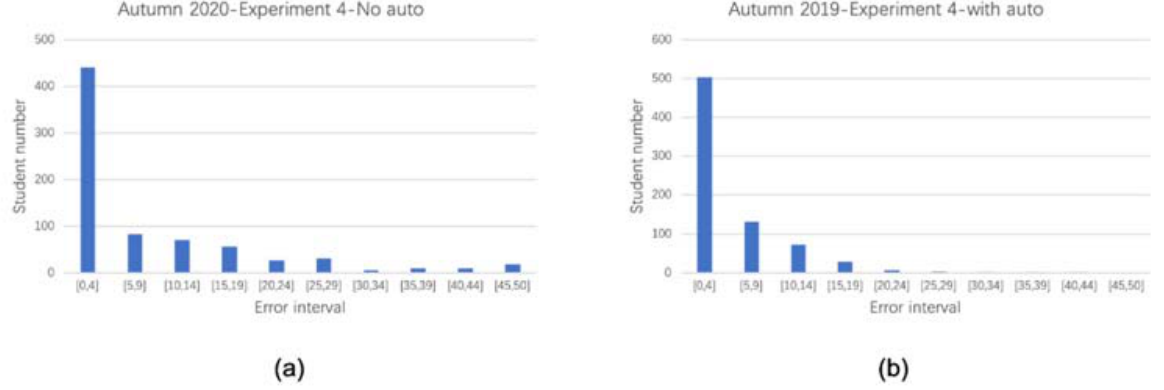
Figure 10. Comparison experiment with and without autograder. ( a ) We added autograder to the peer grading in the autumn of 2020 （ b) We did not add autograder in the peer grading in the au- tumn of 2019.